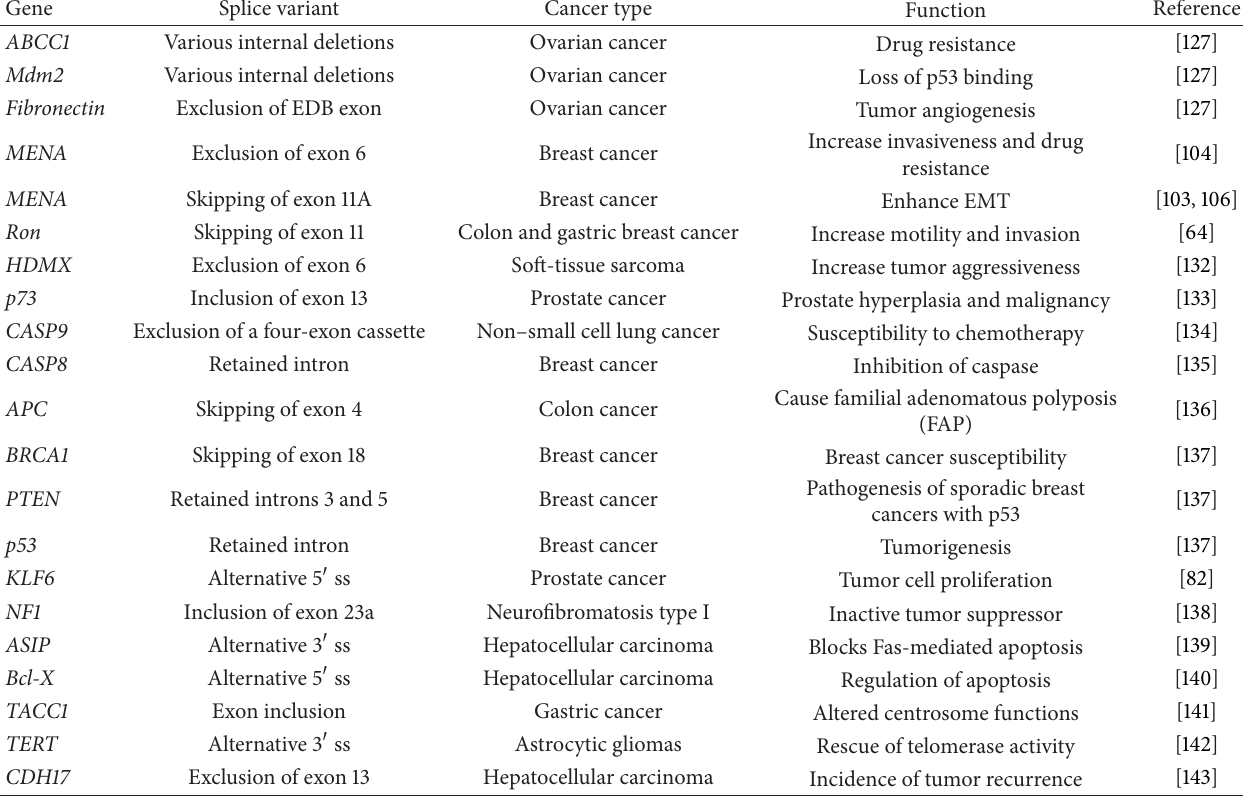
Table 1: Examples of genes that encode cancer-associated alternative splicing